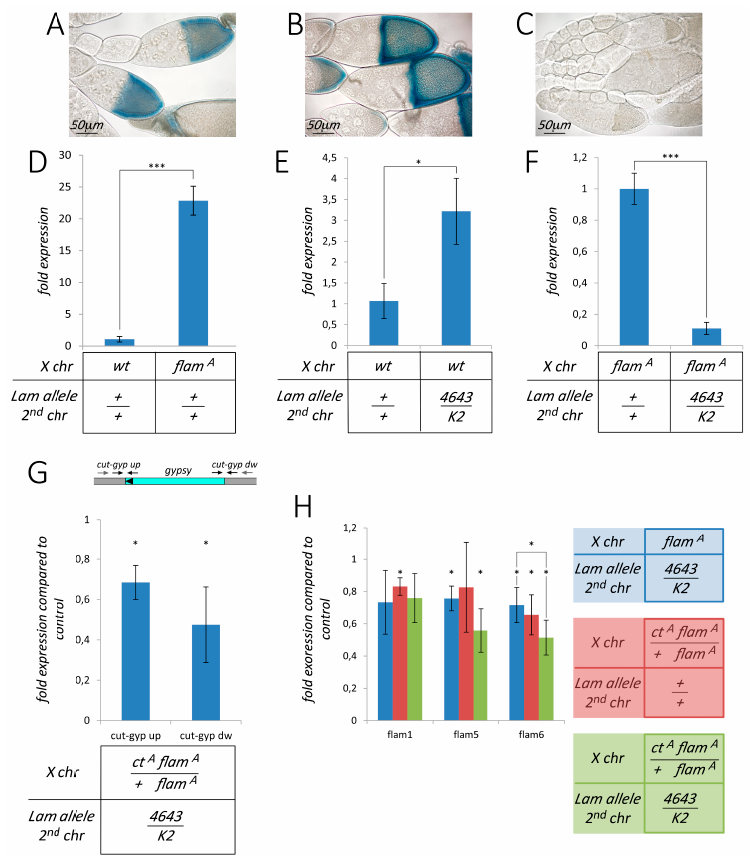
Figure 2. Lam inactivation determines the silencing of gypsy sequences when gypsy is active. ( A – C ) Representative egg chambers subjected to β -galactosidase staining as readout for gypsy-lacZ reporter activity. ( A ) gypsy-lacZ reporter activity is derepressed when the X chromosome from wild type Canton S flies is combined with the Df(1)l11 deficiency encompassing the flamenco locus. ( B ) Derepression of the gypsy-lacZ reporter activity in flies with the X chromosome carrying the permissive flam A allele in combination with the Df(1)l11 deficiency ( Df(1)l11 / flam A ). ( C ) gypsy-lacZ reporter activity of Df(1)l11 / flam A gonads is repressed in the Lam 4643 / K2 genetic background. ( D – H ) Gene expression analysis of gypsy and flamenco sequences in RNAs isolated from female head tissues. wt: X chromosomes from the wild type Canton S strain. flam A : X chromosomes carrying the flamenco permissive allele flam A . ct A : presence of a gypsy -induced mutation in the cut locus. Flies can be homozygous for the wild type Lam allele ( +/+ ) or transheterozygous (4643 / K2). Data are mean values from three independent experiments, and error bars indicate SD (* P < 0.05; *** P < 0.005) ( D ) gypsy expression levels in wild type Canton S (wt) and flam A female head tissues. ( E ) gypsy expression levels in control and Lam 4643 / K2 female head tissues carrying X chromosomes from the wild type Canton S (wt) strain. ( F ) gypsy expression levels in control and Lam 4643 / K2 female head tissues carrying X chromosomes from the flam A strain. ( G ) Upper part: schematic representation of the genomic region containing the 5 (cid:48) upper region of the cut gene (grey) where the gypsy element (cyan) is inserted. The two strand-specific primers used for RT experiments are represented by grey arrows, while the two qPCR couples of primers are represented by black arrows (see Table S1). Lower part: strand-specific qRT-PCR analysis of the transcription levels of the boundaries of the gypsy elements and the surrounding genomic regions of the cut locus ( ct A allele) in ct A flam A / flam A ; Lam 4643 / K2 female head tissues compared to the ct A flam A / flam A ; Lam + control. ct-gyp up is the upstream boundary, and ct-gyp dw is the downstream boundary. ( H ) qRT-PCR analysis of three flamenco fragments in head tissues of flam A females with or without a copy of the ct A allele and carrying wild type or Lam transheterozygous combination compared to the flam A ; Lam + control. flam1 sequence was selected inside the flamenco locus in a region without homology with gypsy , while flam5 and flam6 were selected inside gypsy fragments